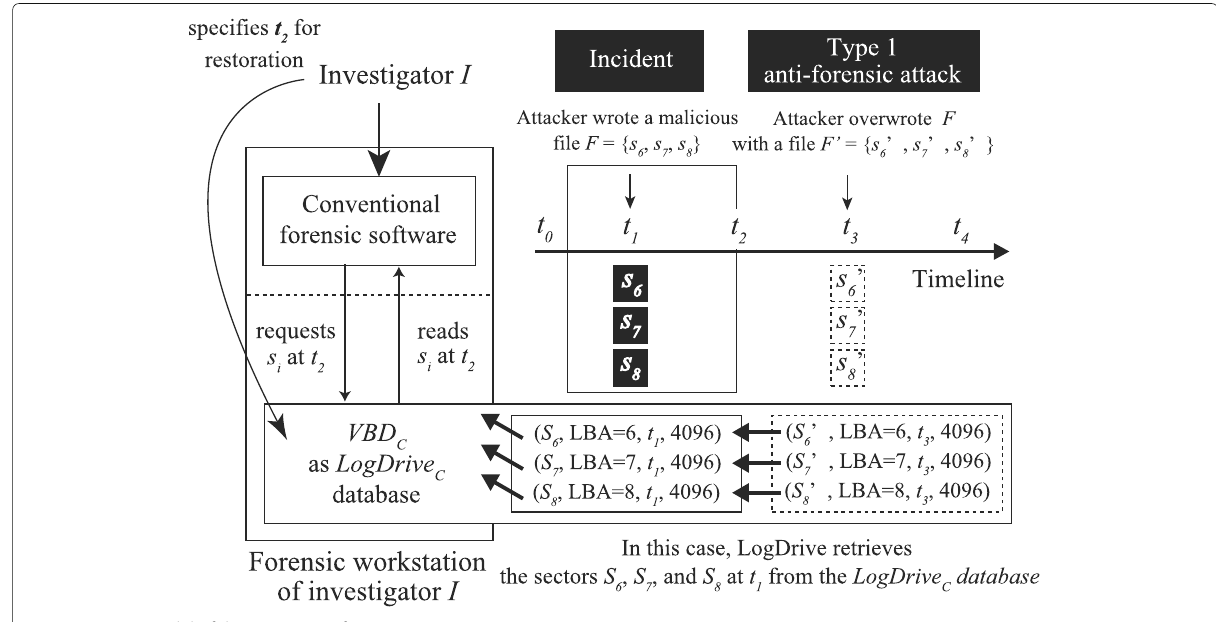
Fig. 5 System model of the restoration function